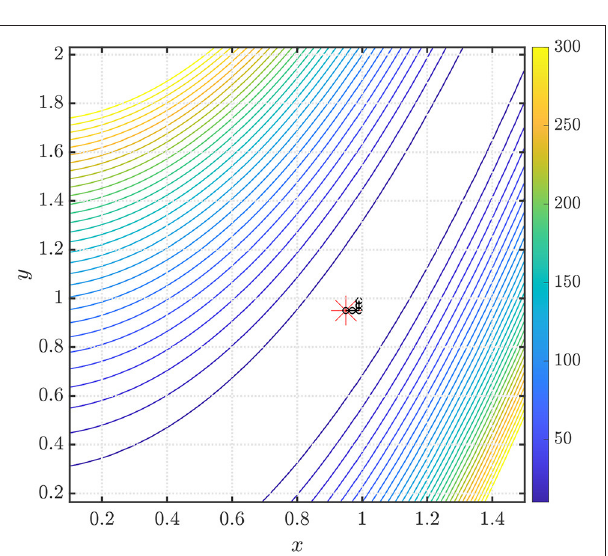
FIGURE 5 | Steps taken in the two-dimensional plane when the NEO method is used to find the global minimum of the Rosenbrock function. The initial point (denoted by the red asterisk) x 0 [0.95 0.95] T . We use ARFIMA(4, d ,0) time = series